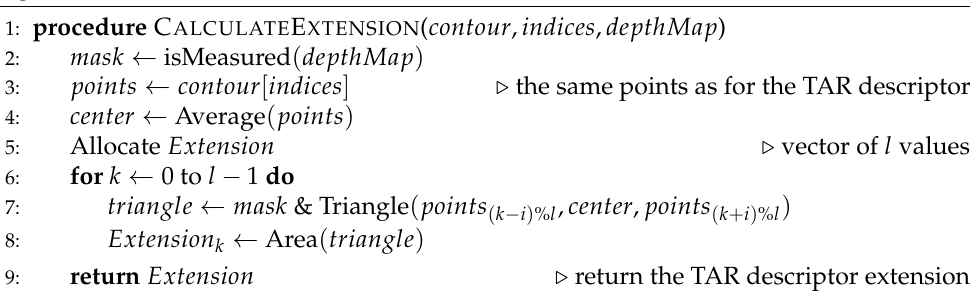
Algorithm 3 Calculation of the TAR